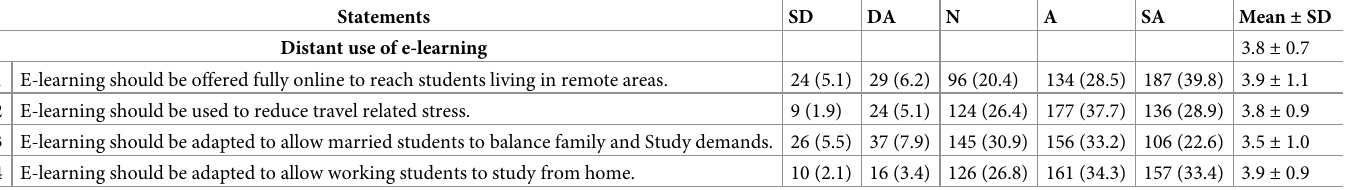
Table 8. Distant use of e-learning (n =